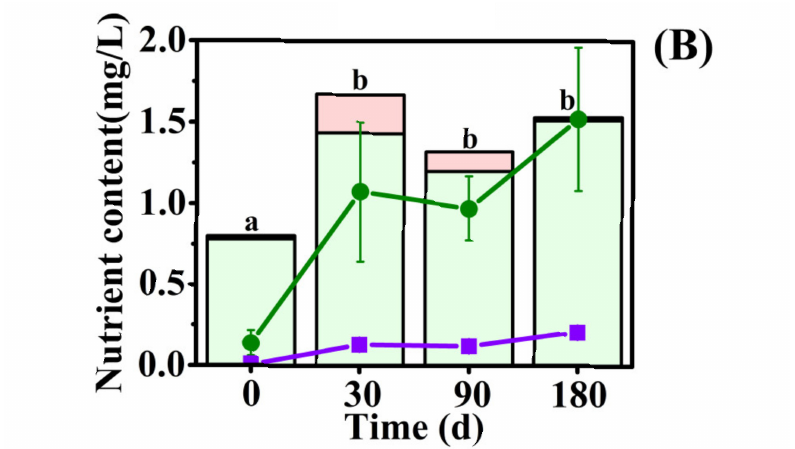
Figure 7. Change in nutrient content in overlying water in the decomposition of E. crusgali ( A ) and B. tripartita ( B ). Error bars indicate ± 1 S.E. Different letters denote a significant difference in total nitrogen and phosphorus in the water between given dates ( p < 0.05).